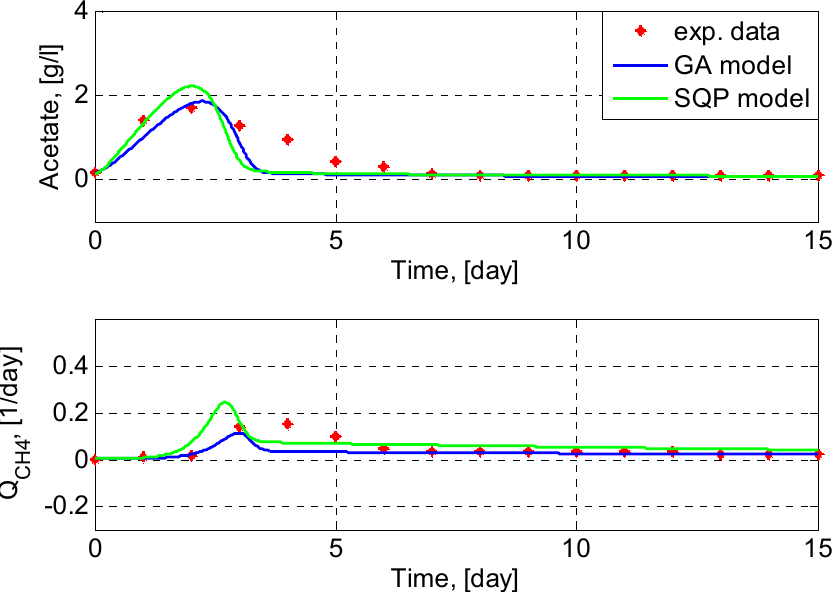
Figure 4. Comparison of the experimental data and model predictions for acetate and methane obtained by GA and SQP models—validation results.